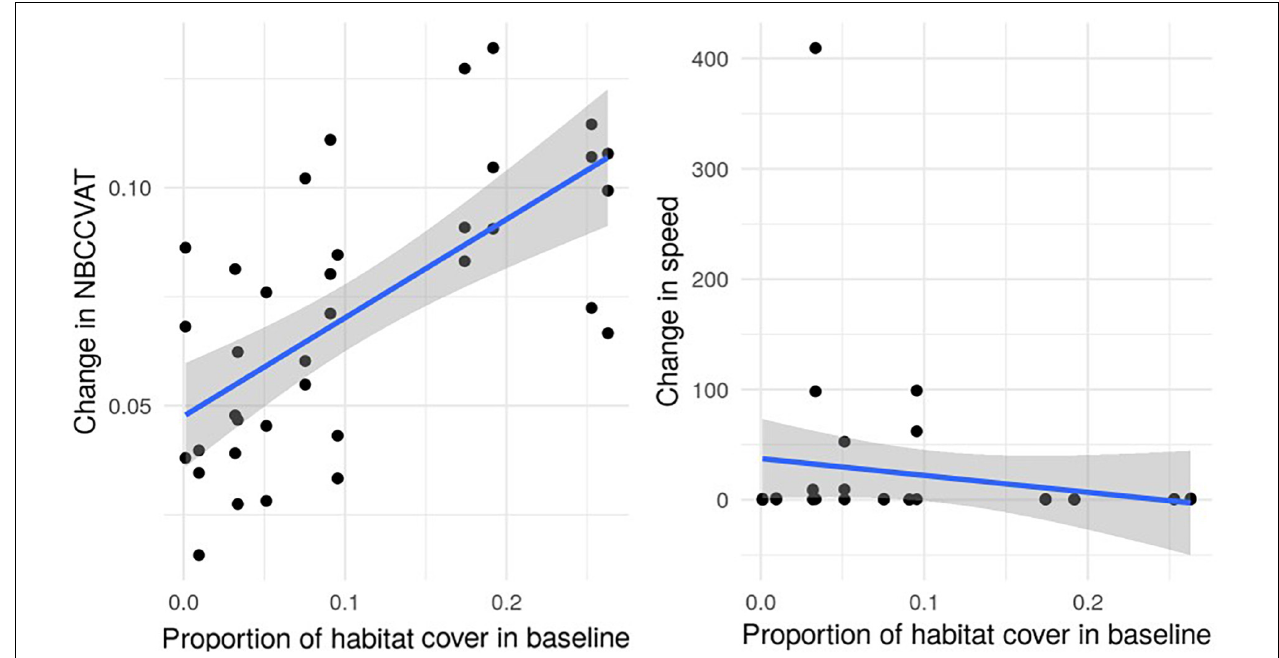
FIGURE 6 | Change in connectivity metrics from baseline in relation to proportion of focal habitat cover. Every point represents the proportional change in the National Biodiversity Climate Change Vulnerability Assessment Tool (NBCCVAT) (left) and speed (right) metric from the baseline for each 10% habitat addition scenario at the county scale against the proportion of focal habitat cover in the baseline landscape. Blue line is the regression line and the gray shared areas are confidence